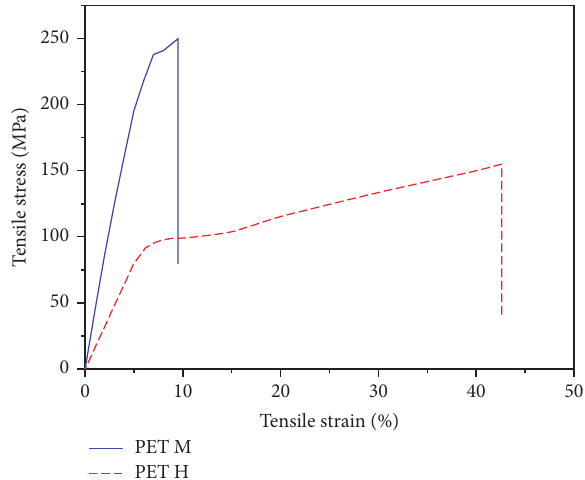
Figure 4: Tensile behaviour of as-spun PET bristles produced from grades H and M, indicating a higher Young’s modulus and ultimate tensile strength for samples produced from grade